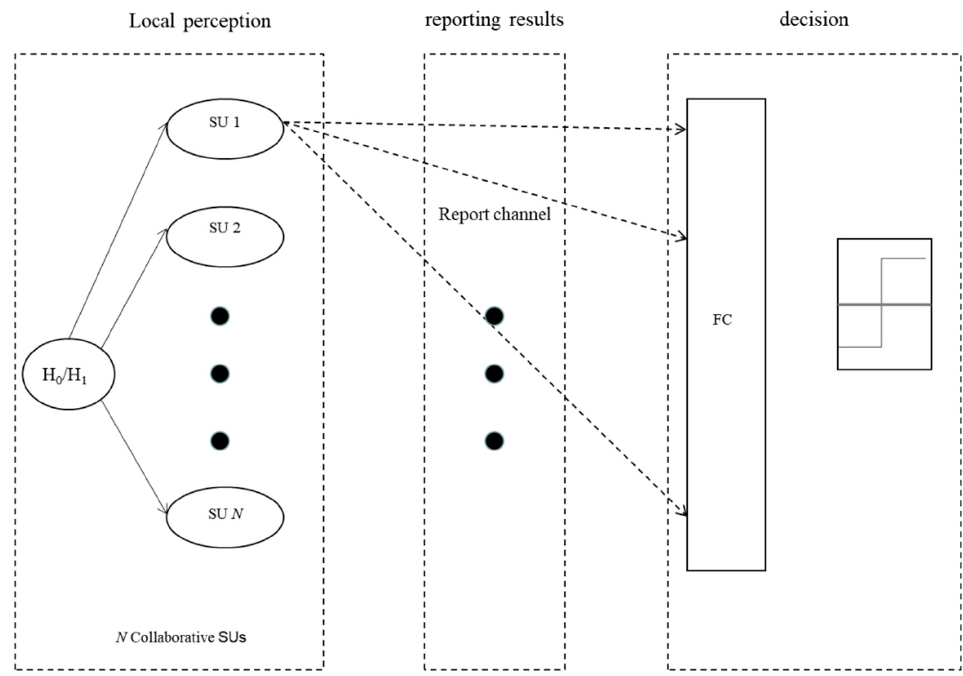
Figure 1. System scenario.